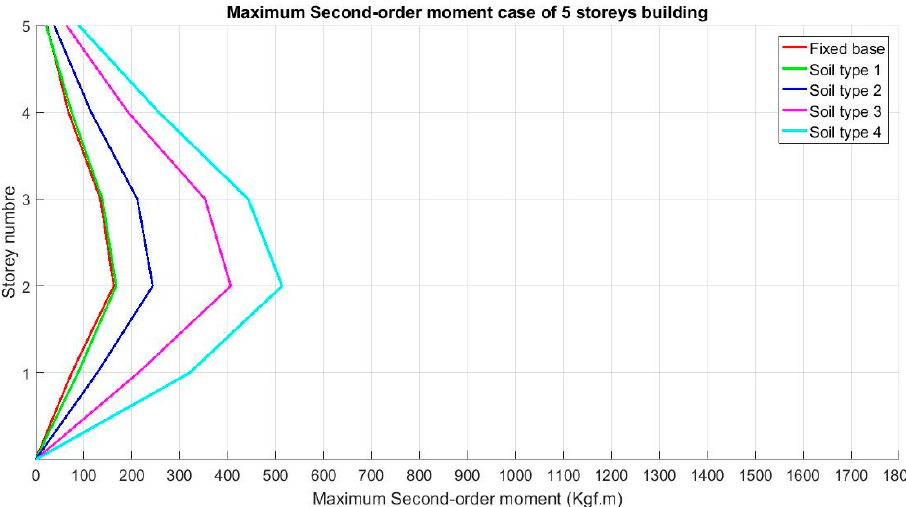
Figure 12. Maximum second-order moment case of an 8-story building .